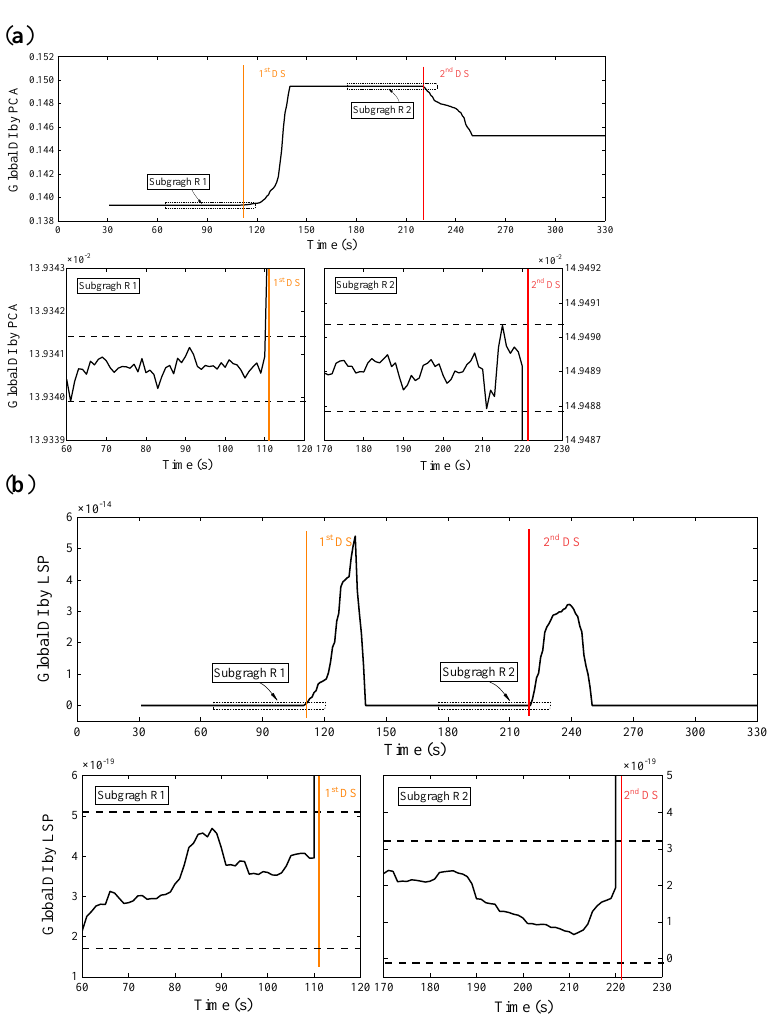
Figure 8. Results of damage detection using WPES-based ( a ) PCA and ( b ) LSP methods, respectively, with a window size of 30 s and a threshold of ±3 standard deviations over 80-s baseline data. For a clear visual comparison of the performance of local damage identification by initial WPES only, WPES-based PCA, and WPES-based LSP, we list the DI values of all elements at the moments of damage initiations (i.e., 1st DS and 2nd DS refer to 111 s and 221 s, respectively) in Figures 10 and 11. It must be stressed that the local DI values by PCA manifest the relative changes due to damages, so identifying local damage needs the current value to be compared with a previous baseline. Otherwise, it is challenging to distinguish damaged elements only by using DI values at different elements, e.g., the DI values of different magnitudes when all elements at any fixed time are taken for analysis in Figure 9a. Therefore, this work uses the deviation obtained from the current DI value minus the baseline/reference value as the improved local DI by PCA in practice, and at the same time taking the consistency into account, the DI values by WPES-only also use the deviation ones. The reference time was first set to 31 s when gained the first local DI